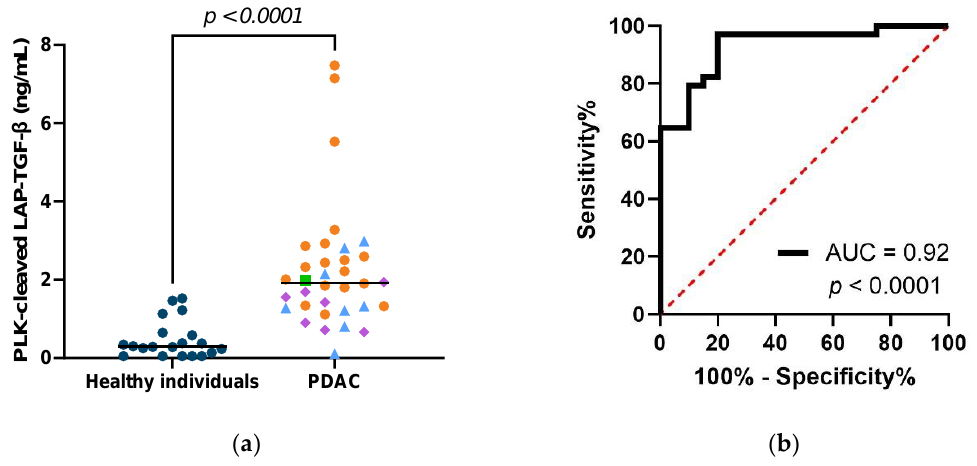
Figure 4. Diagnostic potential of PLK-cleaved LAP-TGF- β: ( a ) Serum levels of PLK-cleaved LAP-TGF- β in healthy indi-